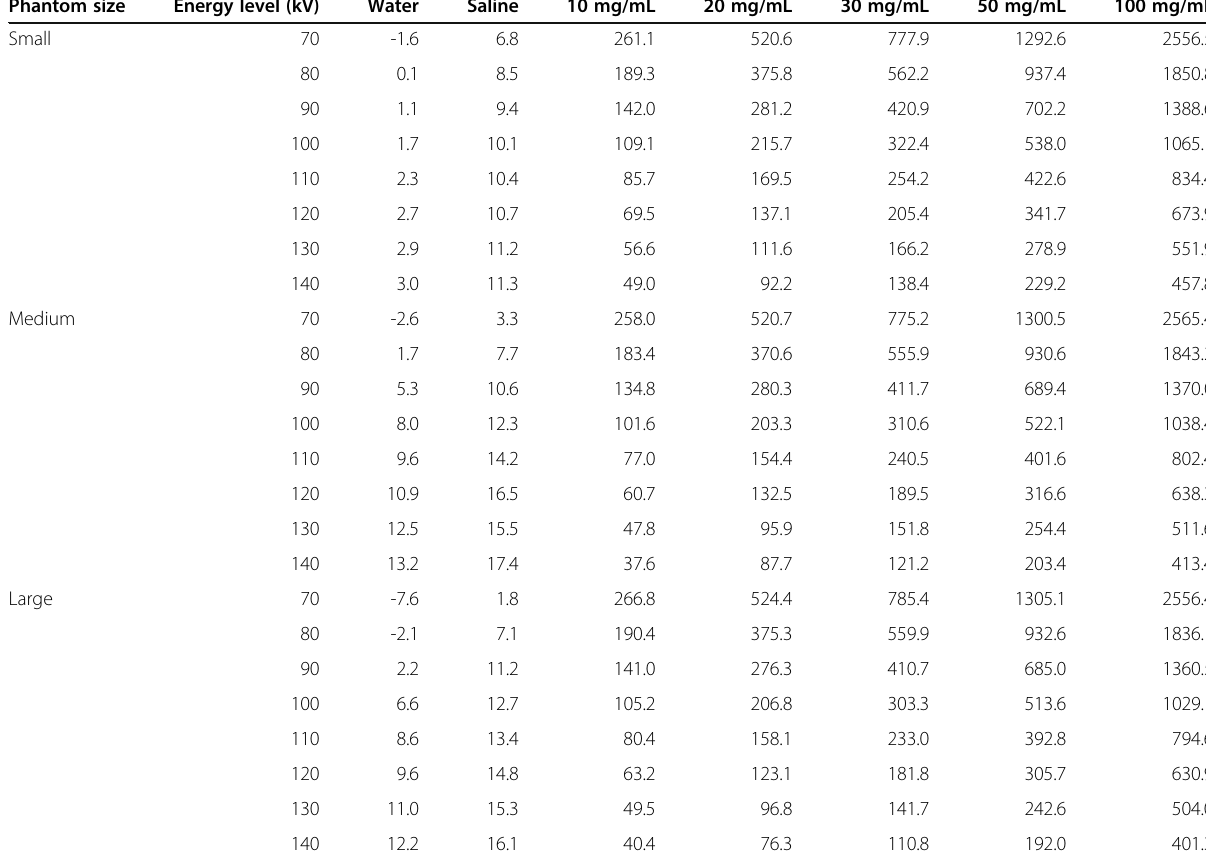
Table 4 Measured HU values in monoenergetic images with General Electric Revolution CT Phantom size Energy level